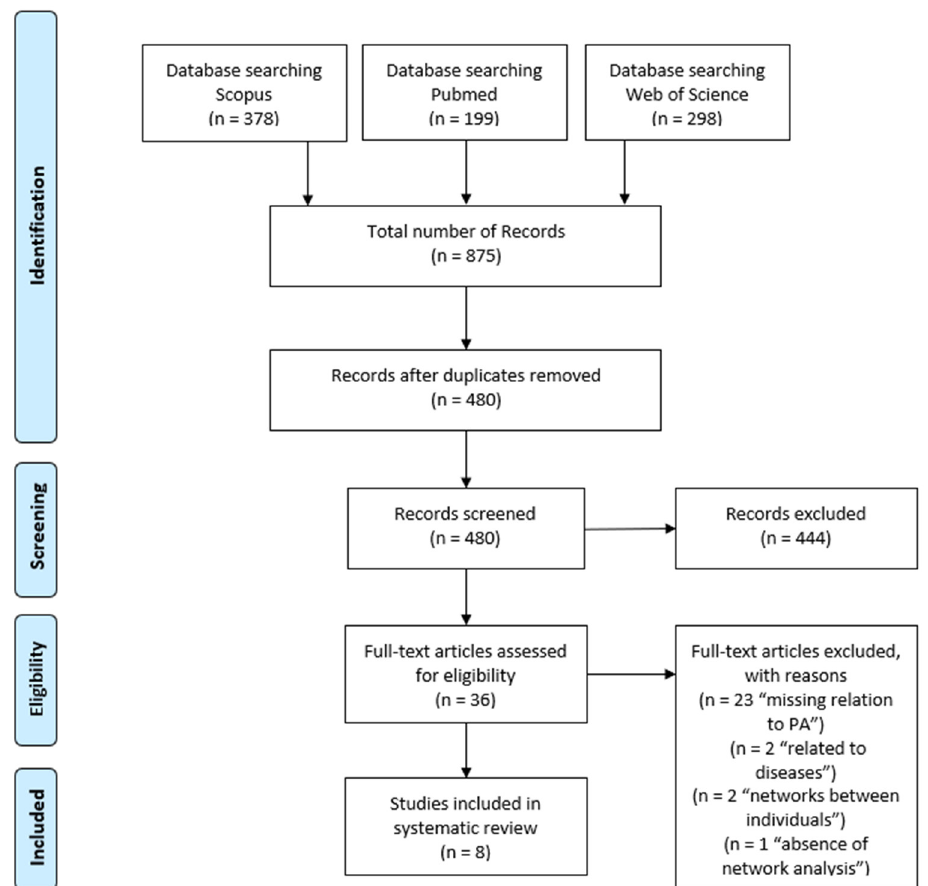
Figure 1. PRISMA flow chart of included studies.